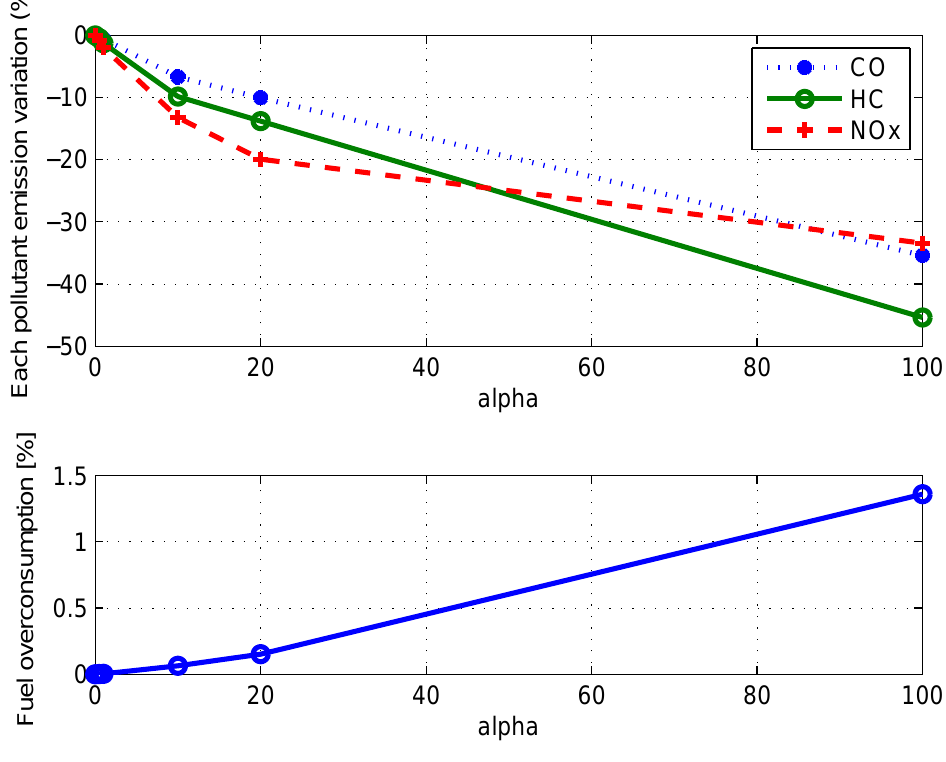
Figure 1. The effect of α on the fuel consumption and pollutant emission for the WLTC (Worldwide Harmonized Light Vehicles Test Cycle).